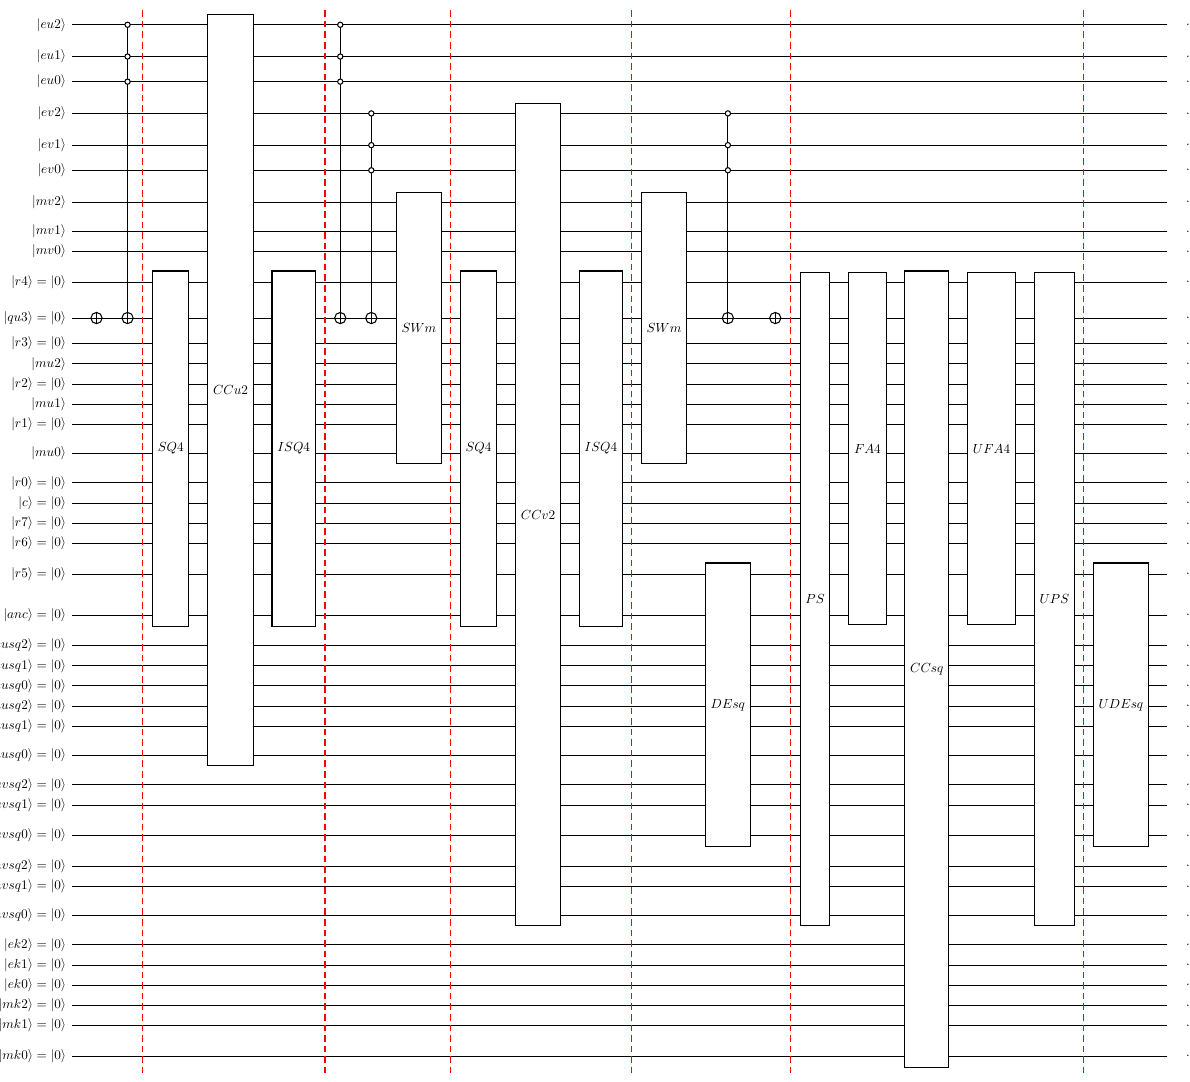
Figure 8. Quantum circuit design Ekin2D1 for the computation of u 2 + v 2 . The floating-point representation uses four mantissa qubits ( N M = 4) and three exponent qubits ( N E =